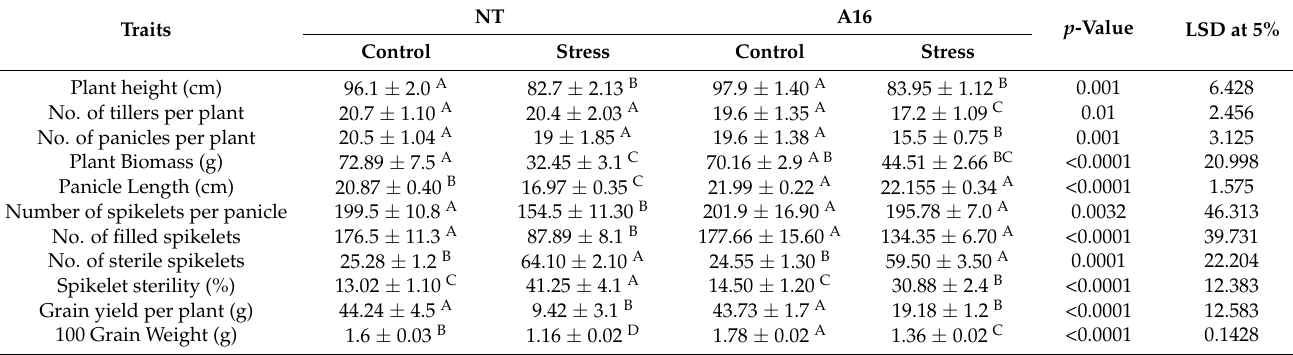
Figure 10. Performance of # A16 under drought in the transgenic screen house facility. ( a ) Overall view of the performance of # A16 over the non-transgenic ADT 43; ( b ) Percent reduction of various yield traits under drought stress. Values are mean of fifteen replications, ** indicates statistical significance at p < 0.01 and * indicates significance at p < 0.05 (ANOVA compared to non-transgenic drought-stressed lines). Table 1. Agronomic performance of non-transgenic and transgenic ADT 43 (T 4 progenies of line # A16) under normal and drought conditions. Values are mean ± standard error of fifteen replications. Means with different alphabet letters are statistically significant using Fisher’s Least Significant Difference.